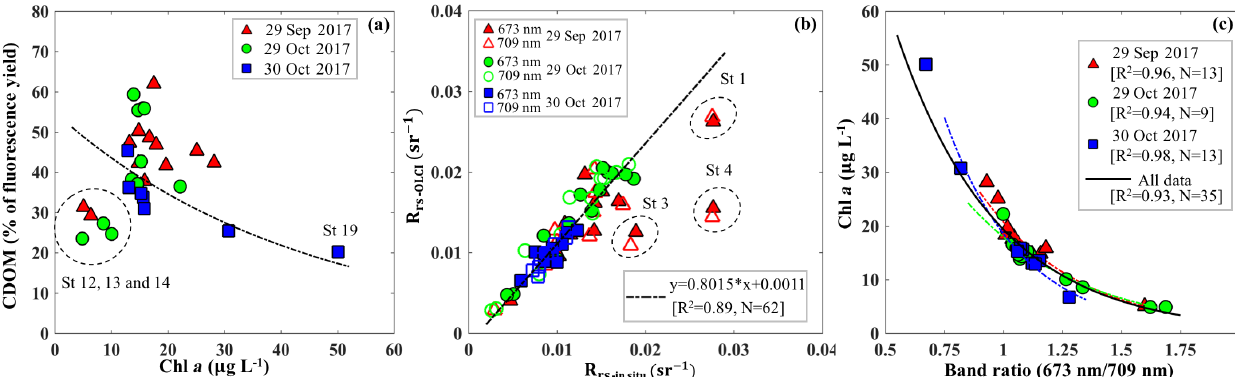
Figure 9. (a) Relationship between the percentage of the fluorescence yield of CDOM measured by FIRe against HPLC-measured Chl a con- centration. The dashed circle corresponds to data acquired in the area adjacent to the GOM. (b) Comparisons between R rs_insitu and R rs_OLCI at band 9 (673nm) and band 11 (709nm). The dashed circles correspond to stations 1, 3 and 4 located close to the river mouth and are con- sidered as outliers. (c) Exponential relationships between HPLC-measured Chl a concentrations and R rs_insitu band ratio (673nm / 709nm) in GB on September 29 ( R 2 = 0 . 89), 29 October ( R 2 = 0 . 93) and 30 October ( R 2 = 0 . 97). Red, green and blue lines and symbols indicate data sets obtained on 29 September, 29 October and 30 October 2017,